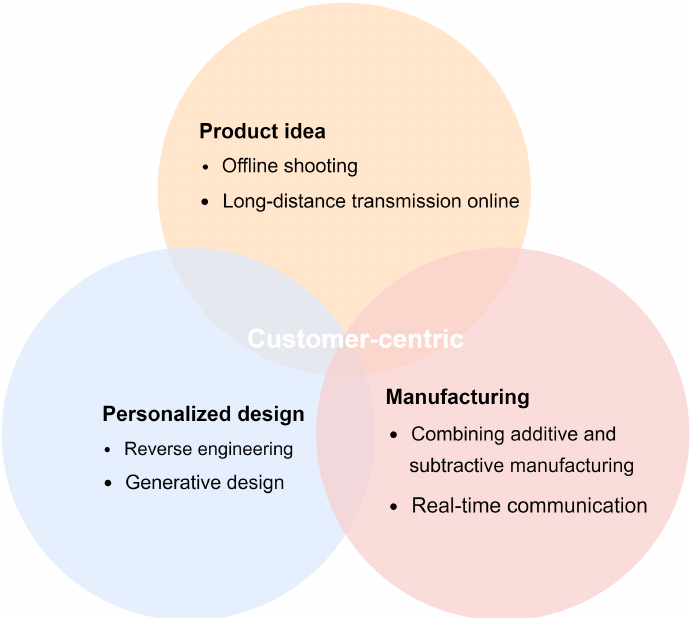
Figure 2. Customer-centric on-demand personalized production model.